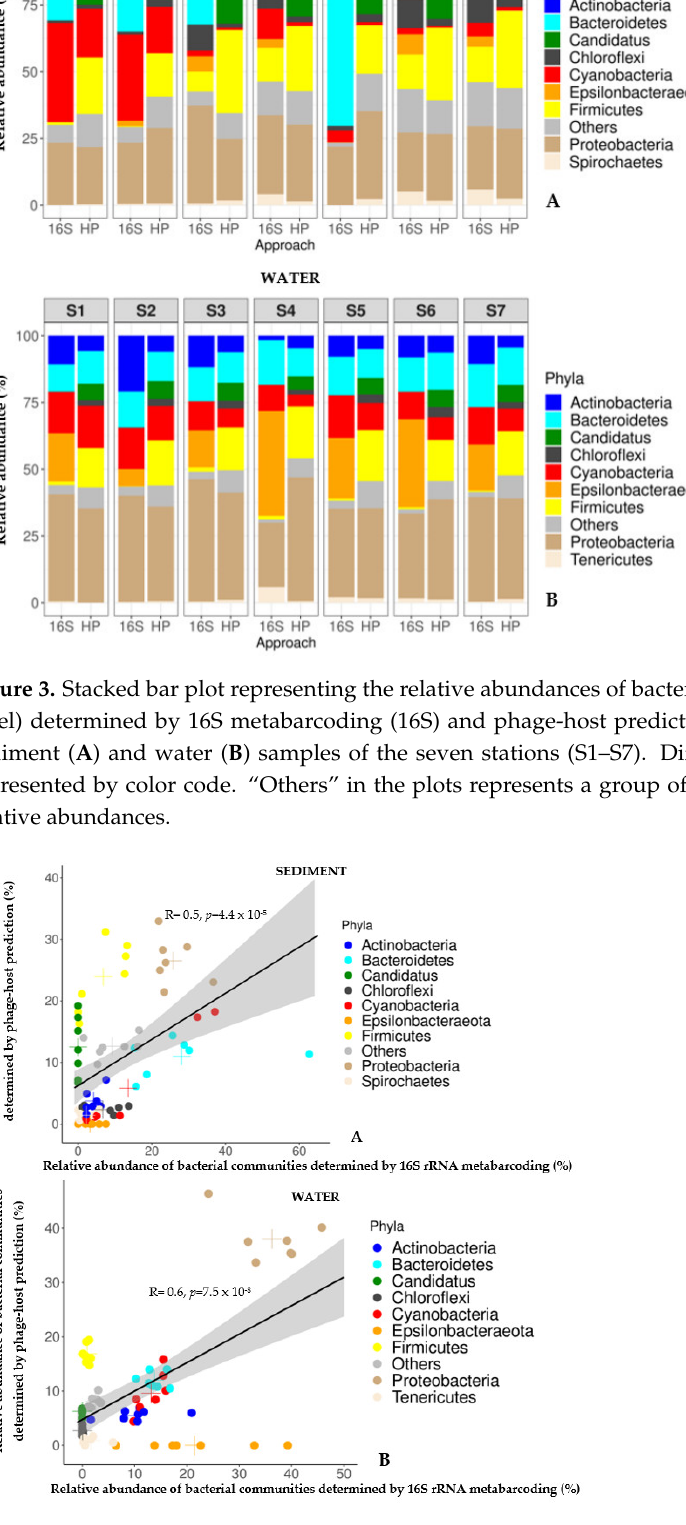
Figure 4. Scatter plot representing the correlation between the relative abundances of bacterial communities (at phyla level) determined by 16S rRNA metabarcoding (16S) and phage-host pre- diction (HP) approach, in the sediment ( A ) and water ( B ) samples of the seven stations (S1–S7). Each colored point corresponds to a single bacterial phylum. Colored crosses ( + ) indicate mean values of relative abundances. The grey areas represent a pointwise 95% confidence interval on the fitted values (regression line). “Others” in the figures represents a group of bacterial phyla with <1% relative abundances. R: Spearman rank correlation coefficients, p = p value.